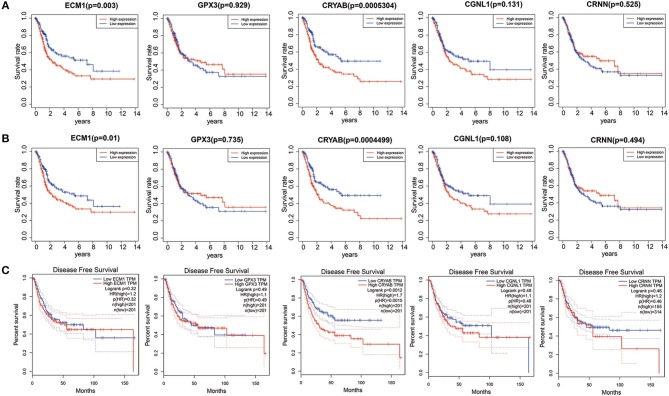
Kaplan-Meier (KM) curves for prognostic values of ECM1, GPX3, CRYAB, CGNL1, and CRNN. (A) Overall survival (OS) based on TCGA BLCA dataset; (B) OS based on high-grade bladder urothelial carcinoma in TCGA BLCA dataset; and (C) Disease free survival (DFS) based on Gene Expression Profiling Interactive Analysis (GEPIA).